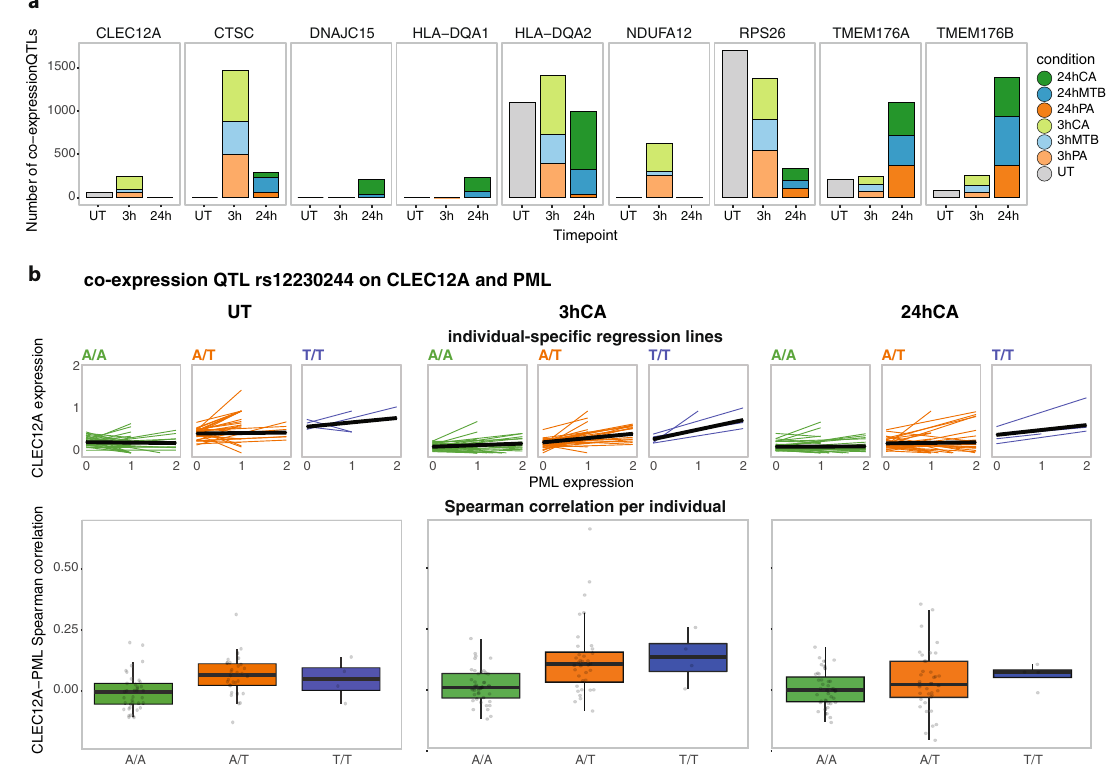
Pathways in CLEC12A co-expression QTLs